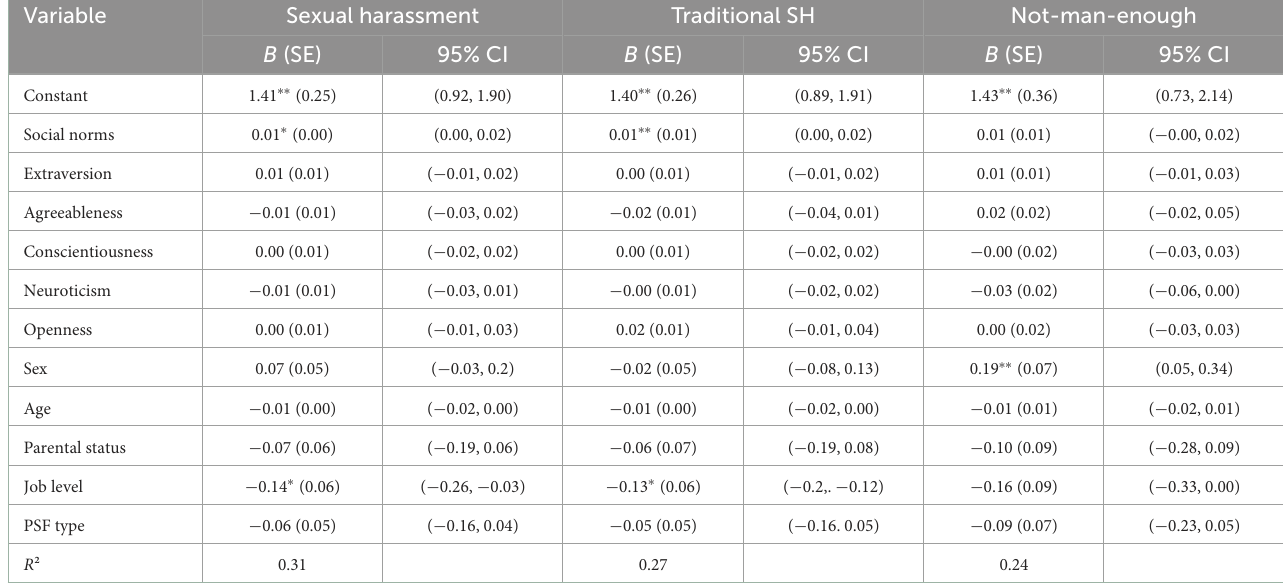
TABLE 2 Predictors of self-reported experienced workplace sexual harassment ( N = 321).